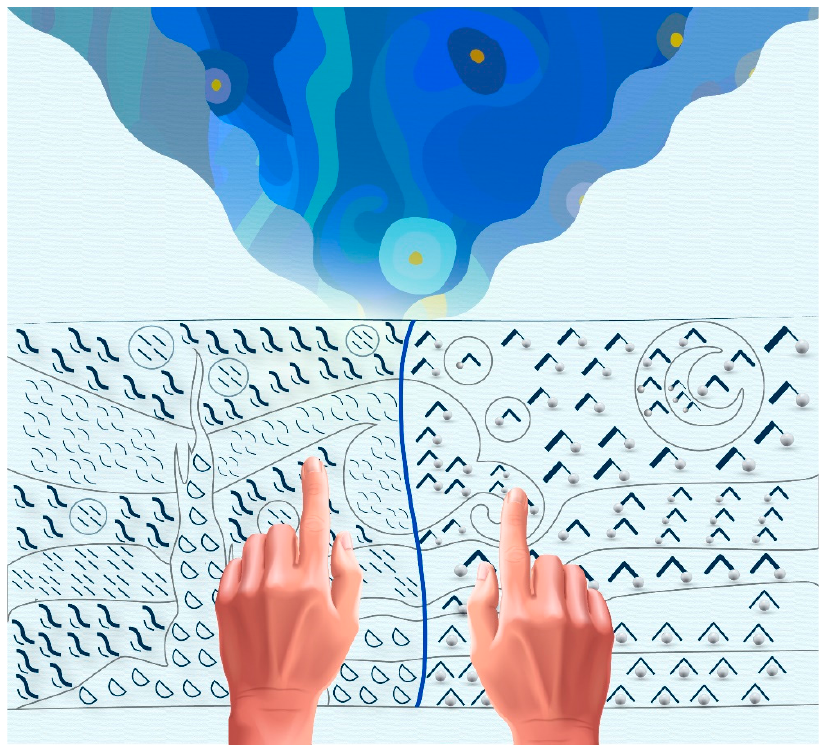
Figure 4. Two tactile color pictograms, Cover image of [87], Editing Services, Wiley. Dec. 2020 .